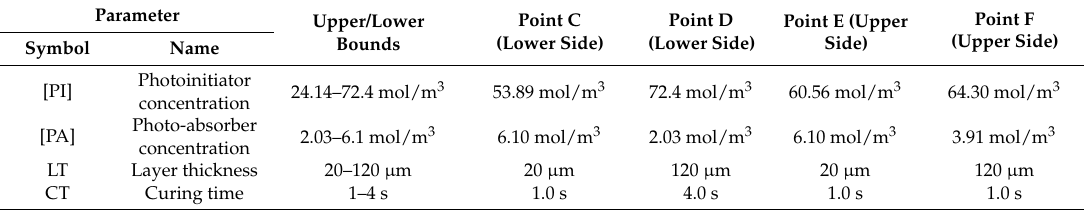
Table 9. List of optimizing parameters.